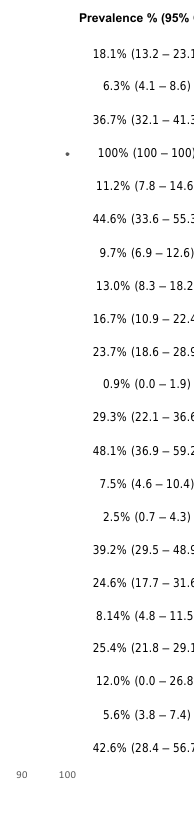
Figure 4. Reported prevalence of Giardia in the included studies by microscopy. [37 –